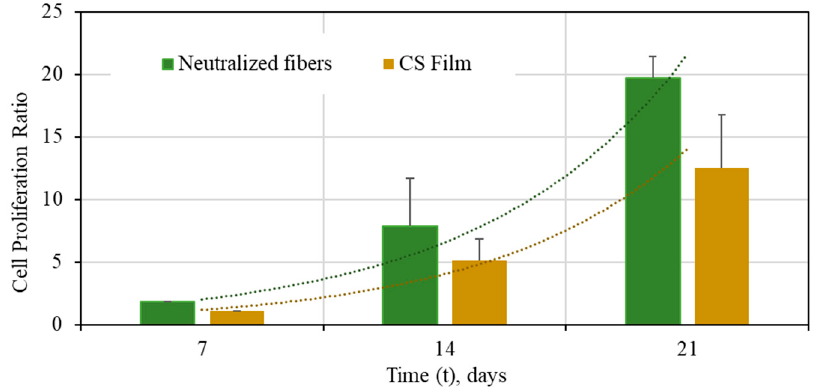
Figure 8. Cell proliferation ratios for chondrocytes on CS/PEO fibers produced from PEO, MW = 5000 kg/mol: pure chitosan fibers ( (cid:4) ) and CS films ( (cid:4) ). Error bars represent mean ± SD; n = 4 and n = 3 for fiber mats and CS films, respectively.